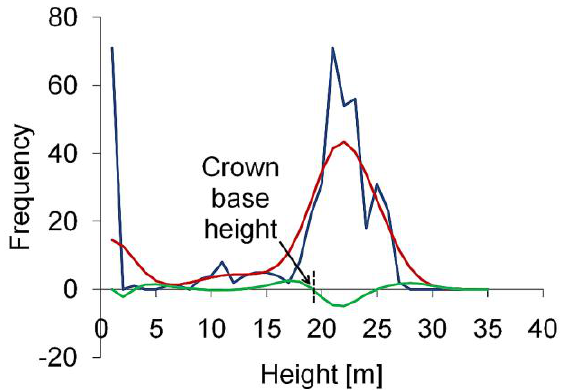
Figure 5. Estimation of the crown base height cbh using the height distribution of laser reflections according to [7], Blue: height distribution function, Red: smoothed height distribution function, Green: second derivative of the smoothed height distribution